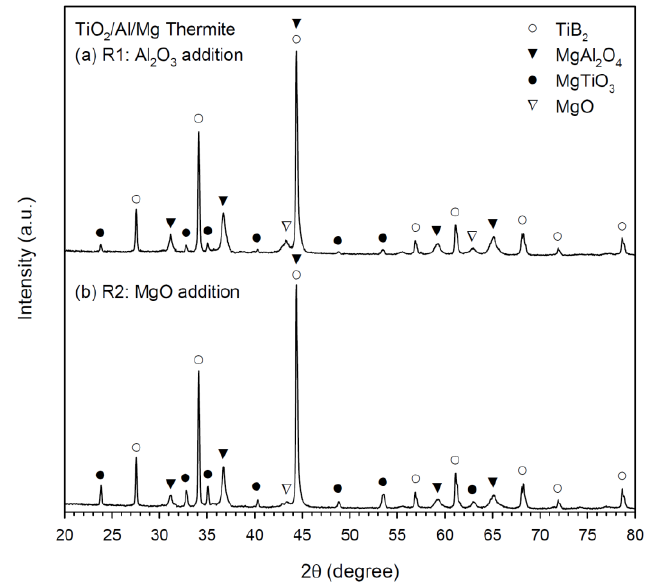
Figure 5. XRD patterns of TiB 2 /MgAl 2 O 4 composites obtained from SHS reactions of ( a ) Equation (1) and ( b ) Equation (2).